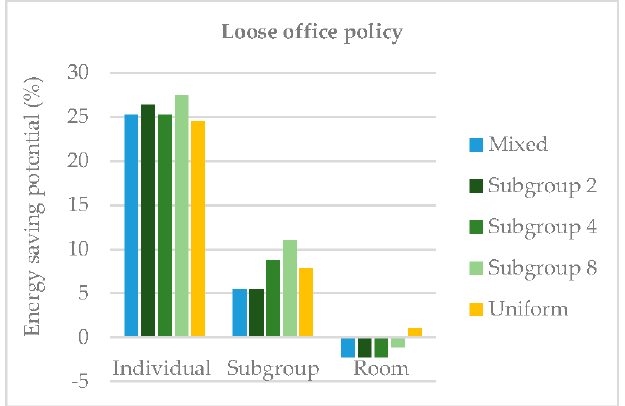
Figure 13. Energy saving potential of the three control strategies for the five function distributions with a strict office policy.